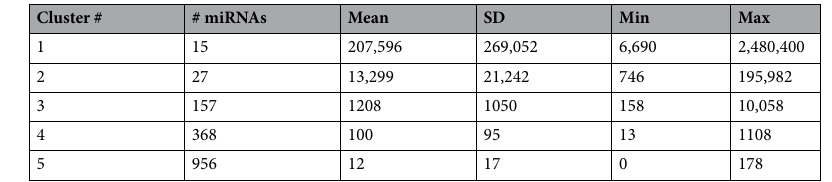
Table 3. Summary statistics for expression of human milk extracellular vesicle miRNAs in the 5 clusters. SD standard deviation, Min minimum value, Max maximal value. *Counts are median ratio normalized with DESeq2.